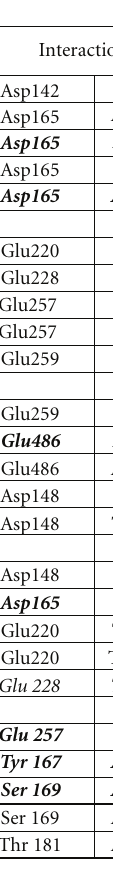
Figure 7: Residue-residue interactions identified in the four MD trajectories together with their residence times. A: ligand-free M3 trajectory in POPC; B: ligand-free M3 trajectory in POPC/POPS; C: M3-NMS complex in POPC; D: M3-NMS complex in POPC/POPS. Color scale: black, the interaction in present during the whole trajectory; grey, the interaction is present more than 50% of the trajectory; light grey, the interaction is present less than 50% of the trajectory. Residues in bold are those found in rhodopsin (Cordomi and Perez, 2007). Residues in italics are tentatively involved in the ion lock of M3R.